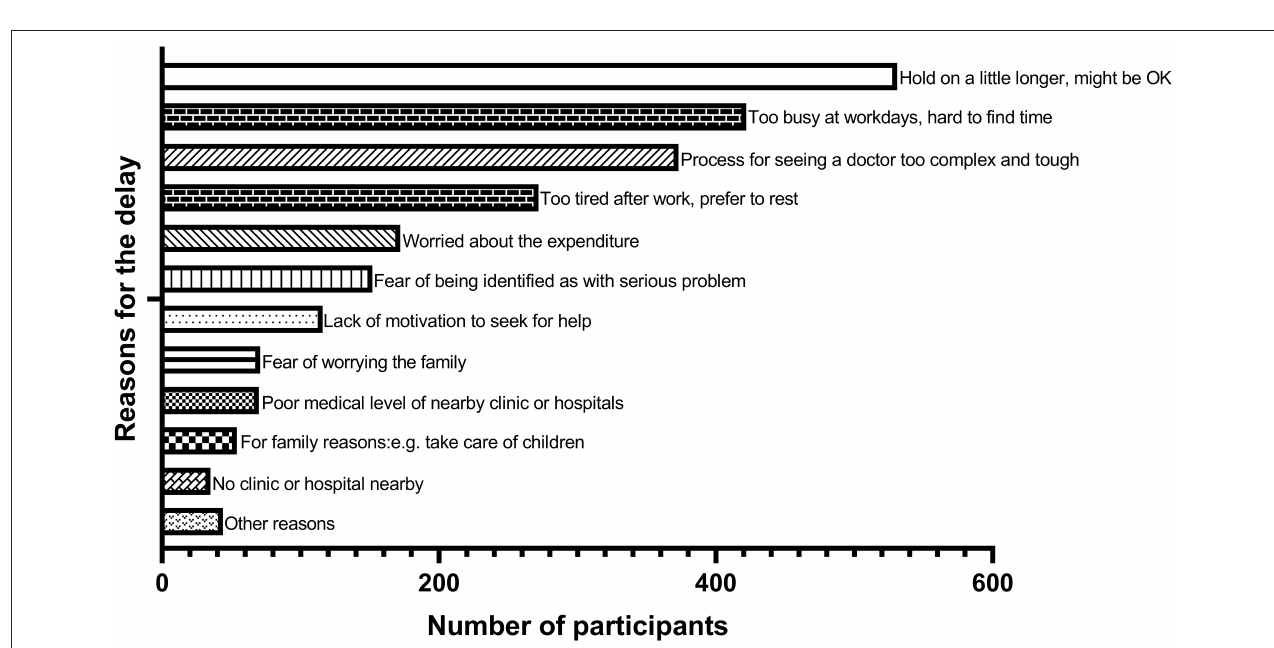
FIGURE 2 | Ranking for reasons of the delay for seeking medical help ( N =